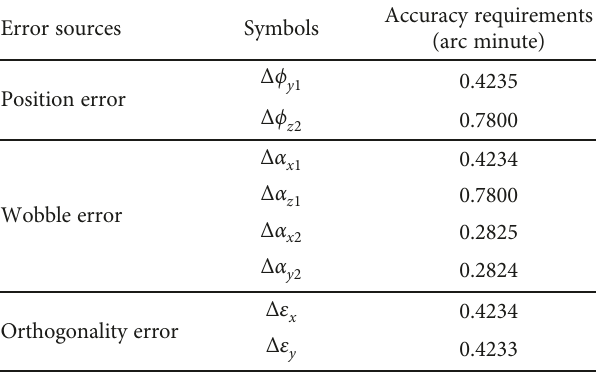
Table 4: Error allocation results of the turntable